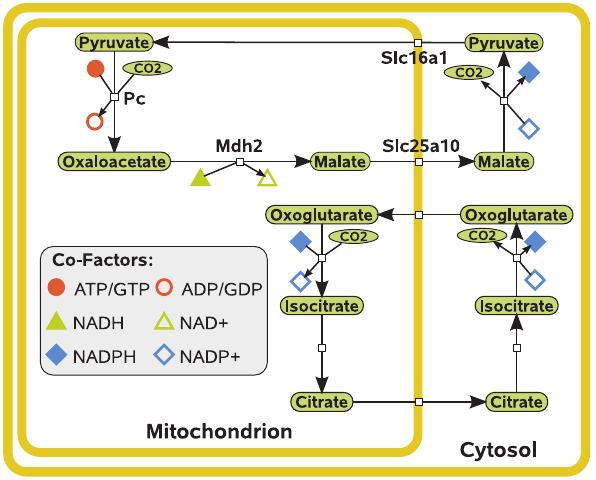
Figure 5. Pathways for cytosolic NADPH production from mitochondrial NADH/NADPH. The upper pathway depicts the transfer of electrons from mitochondrial NADH to cytosolic NADPH. The lower pathway depicts a transfer of electrons from mitochondrial NADPH to cytosolic NADPH. Please note that the second pathway involves the transport of oxoglutarate and citrate over the mitochon- drial membrane and necessitates the antiport of L-malate and phosphoenolpyruvate, respectively. A list of enzymes can be found in Table S1.